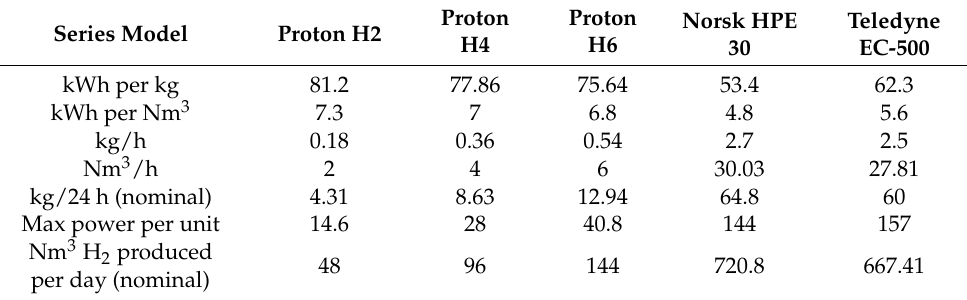
Table 1. Characteristics of commercial electrolyzers.